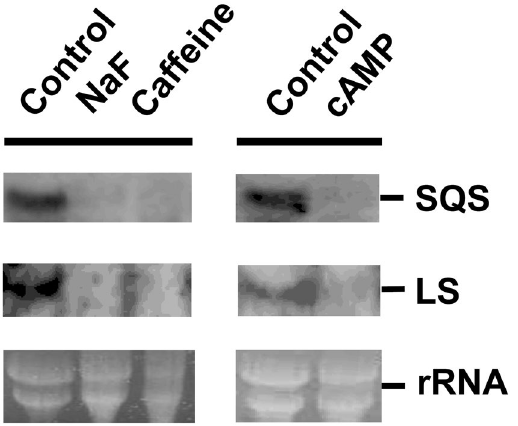
Figure 7. Effect of cAMP on the mRNA expression levels of squalene synthase (SQS) and lanosterol synthase (LS) in Ganoderma lucidum . G. lucidum mycelium was incubated with 40 mM caffeine, 10 mM NaF, or 40 mM cAMP/15 mM IBMX for 12 h. Northern blotting was then performed to detect the expression of the SQS and LS genes. Gels stained with ethidium bromide are shown to indicate the relative total RNA loading.